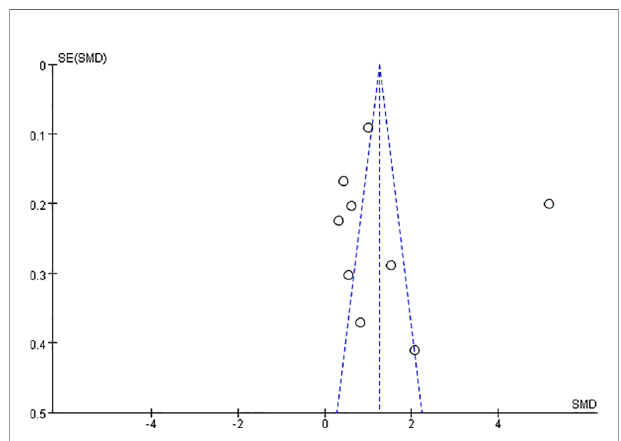
FIGURE 6 | Funnel plot of BMD changes between bisphosphonate and